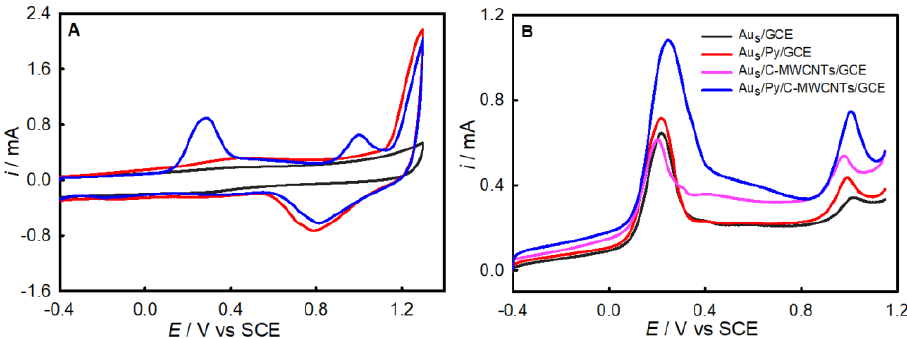
Figure 5. ( A ) CV curves on GCE (black) and Au s /Py/C-MWCNTs/GCE (blue) in 0.1 M aqueous H 2 SO 4 containing 1.0 μM As(III) and on Au s /Py/C-MWCNTs/GCE in As(III)-free 0.1 M aqueous H 2 SO 4 (red); ( B ) LSASV response on the Au-modified electrodes in 0.1 M aqueous H 2 SO 4 containing 1.0 μM As(III). The experiments were conducted after preconcentration at − 0.40 V for 7 min. Scan rate: 5 V s − 1 .